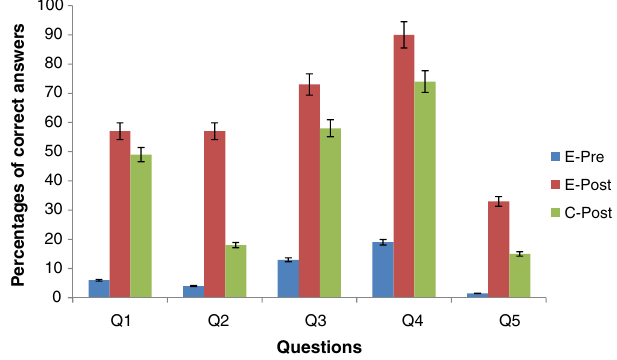
FIG. 1. The percentages of correct answers are shown in the experimental pretest (E-Pre) and post-test (E-Post) and in the comparison groups ’ post-test